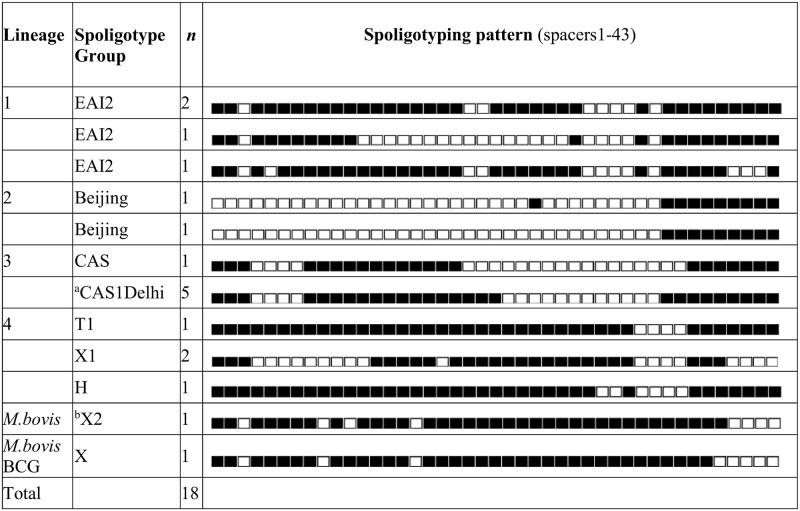
Distribution of in silico generated spoligotypes across the culture-positive Tasmanian TB isolates analysed from 2014–2016.aThe in silico derived spoligotype of the four Tasmanian Lineage 3 cluster isolates (RHH3, RHH11, RHH13, RHH14) and a fifth Lineage 3 isolate (RHH10) matched Spoligotype International Type 26 of the CAS1_Delhi spoligotyping family which accounted for approximately 50% of Lineage 3 M. tuberculosis isolates in Nepal in a previous analysis [21]. bThe in silico derived spoligotype of the M. bovis isolate (TASMB14) matches that of human M. bovis cases that were reported in other Australian states/territories between 1977 and 1989 [22].